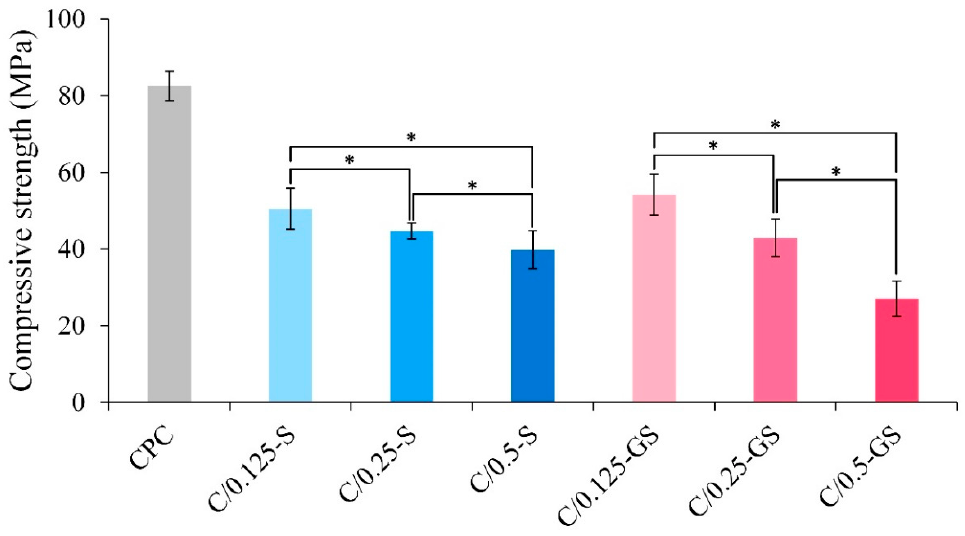
Figure 2. Compressive strengths of CPC/hydrogel composites after immersion in Tris-buffer solution for 1 day ( n = 10; * indicates significant difference at p < 0.05).